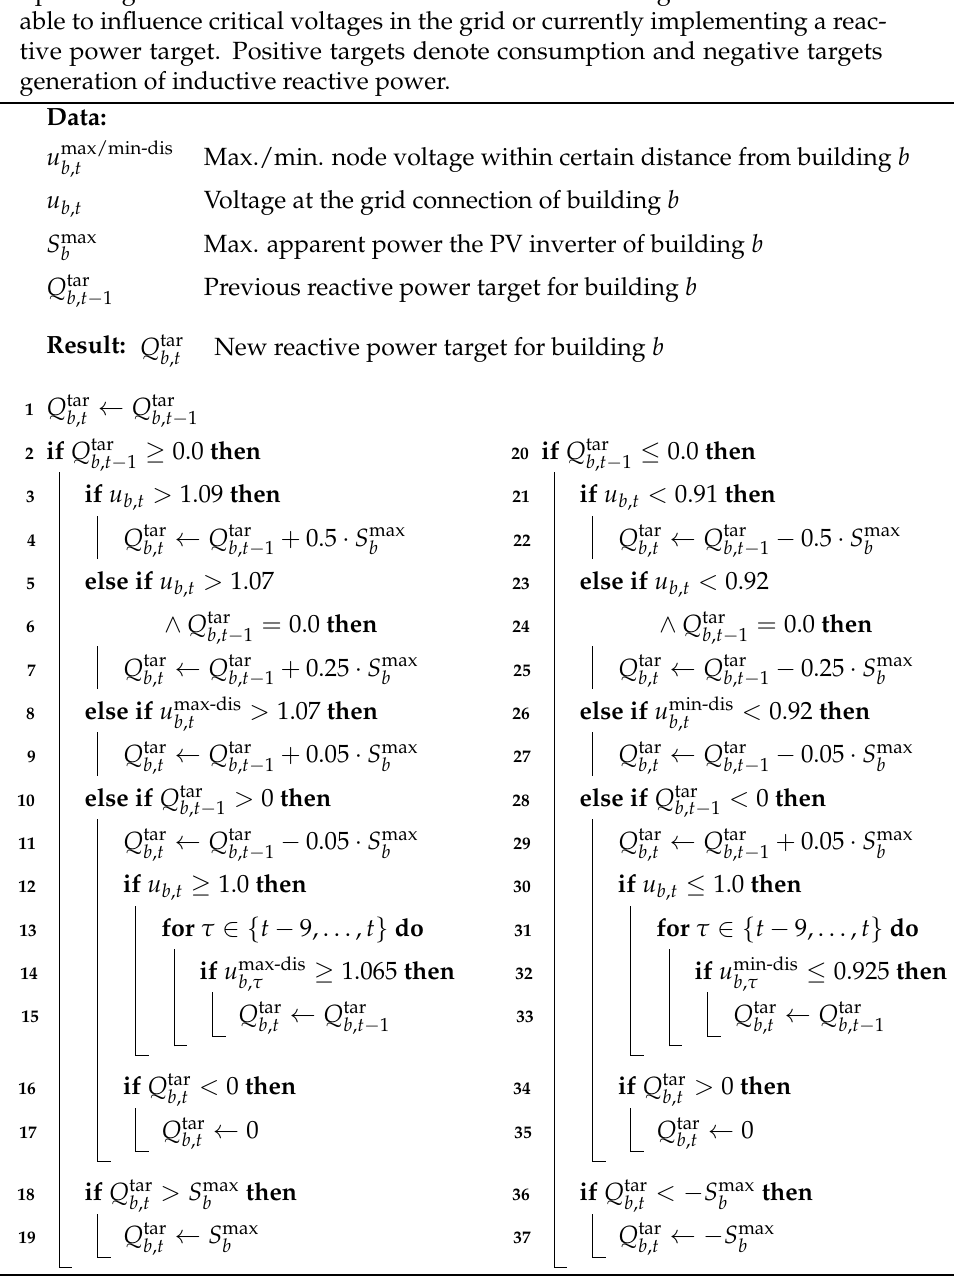
Algorithm 1: The determination of reactive power targets by the DSO in the centralized grid control strategy. The DSO performs this algorithm each time updated grid status data are received and for all buildings determined to be able to influence critical voltages in the grid or currently implementing a reac- tive power target. Positive targets denote consumption and negative targets generation of inductive reactive